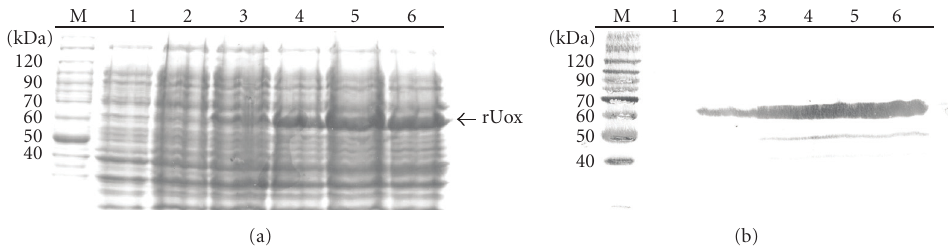
Figure 1: Small-scale expression and time course study of urate oxidase expression in E. coli . Comassie Blue stained 12% SDS-PAGE (a) and respective Western blotting analysis (b) of urate oxidase induction in E. coli . Lane M, protein BenchMarker (Invitrogen); Lane 1, supernatant of uninduced cells; Lanes 2–6, supernatant of induced cells after 15, 30, 60, 90, and 120 minutes, respectively. The arrow indicates the position of the band corresponding to recombinant urate oxidase (rUox).